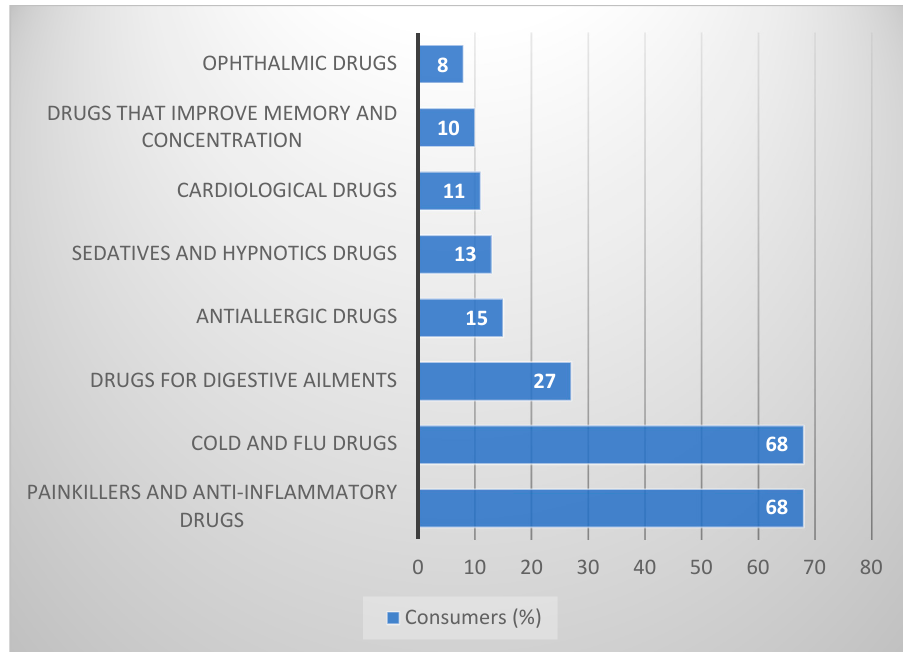
Figure 2. Consumers (%) using OTC drugs. Source: own study based on [10].